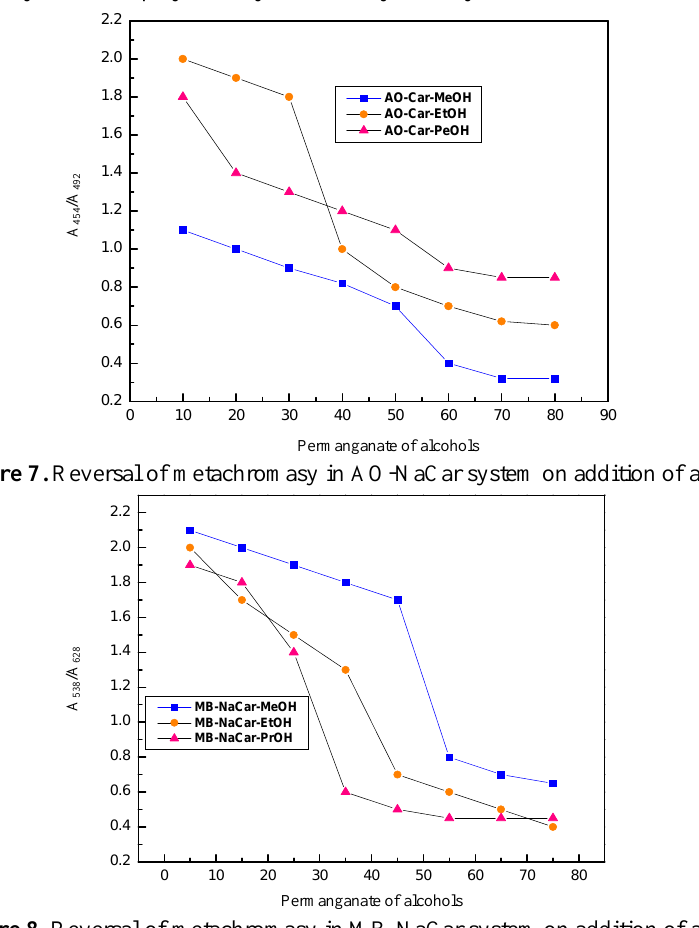
Figure 8. Reversal of metachromasy in MB-NaCar system on addition of